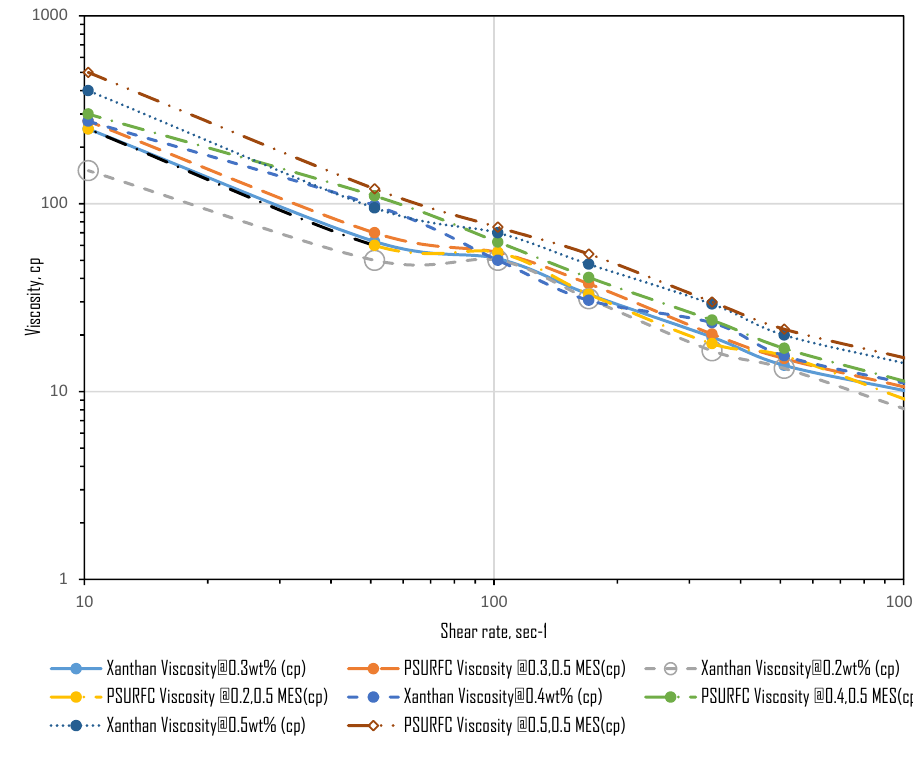
Fig. 7 Summary of rheologi- cal studies. Viscosity vs shear rate analysis for Xanthan gum and PSURFC. Experimental condition: concentration